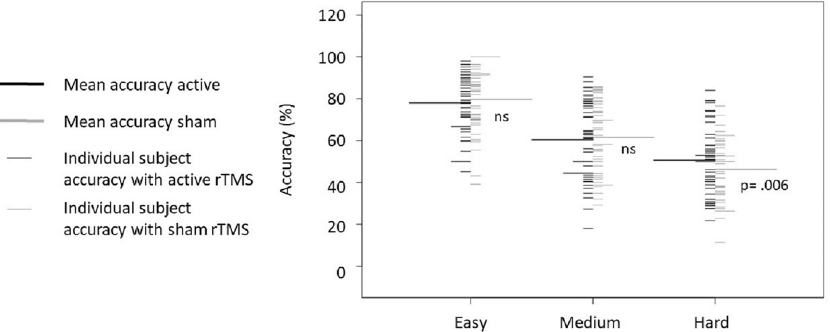
Fig 5. Mean accuracy in the Invalid trials. Accuracy for active (black) and sham (grey) rTMS are displayed for each difficulty level. Small lines represent individual data. The longer lines represent the average for each condition.